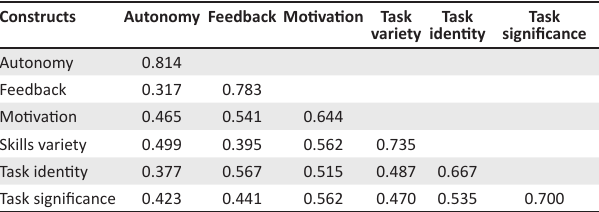
TABLE 3: Path model results of structured equation modelling